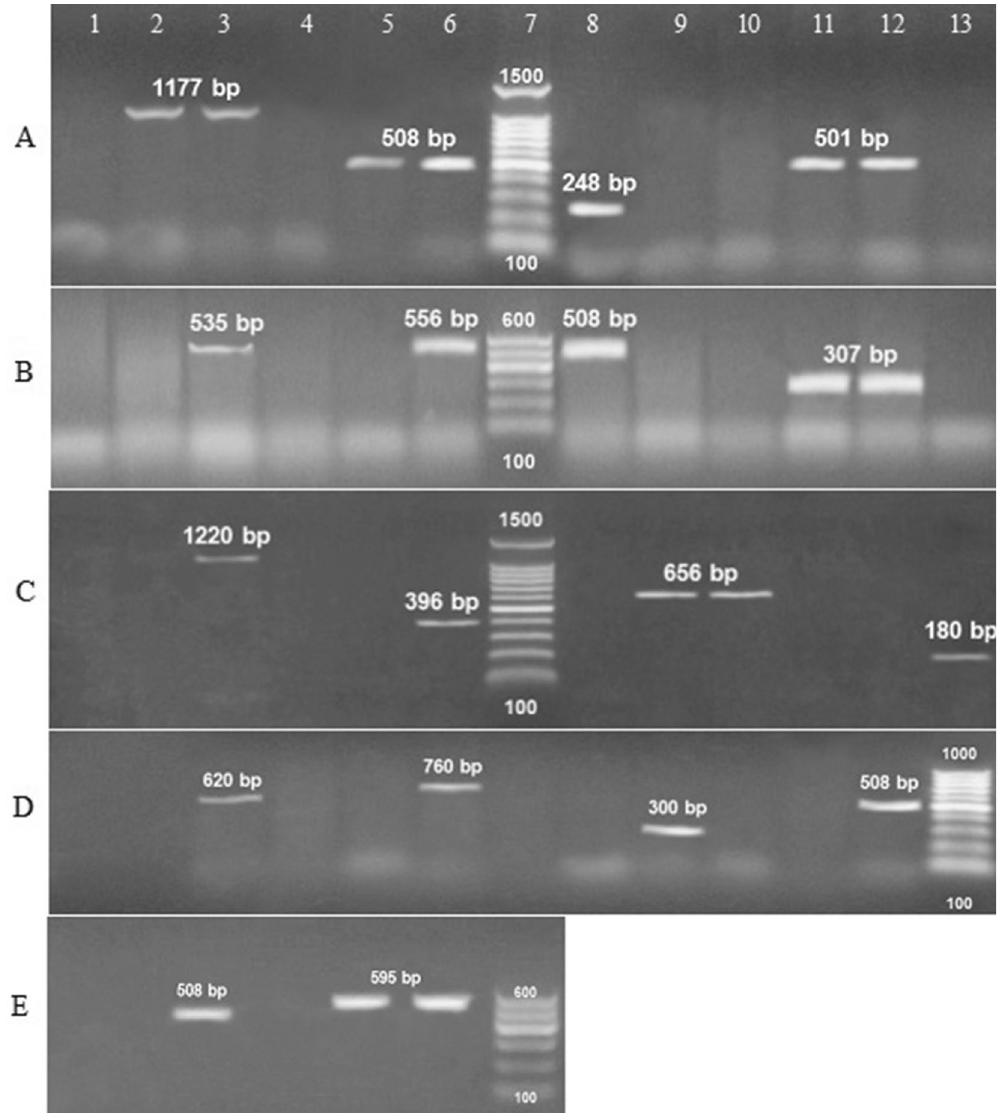
Figure 1. 1.5% agarose gel electrophoresis of multiplex PCR of virulence genes characterized for the isolated uropathogens. ( A ) E. coli ; Lane 1, 4, 10, 13: negative control for detected genes; Lane 3, 6, 8, 11 positive control of DNA confirmed by reference laboratory for quality control; Lane 2 hly (1,177 bp), Lane 5 fim H (508 bp), Lane 9 negative eae A (248), Lane 12 pap C (501 bp); Lane 7 Gel Pilot 100 bp plus ladder (cat. no. 239045) supplied from QIAGEN (USA). ( B ) Klebsiella pneumoniae ; Lane 1, 4, 10, 13: negative control for detected genes; Lane 3, 6, 8, 11 positive control of DNA; Lane 2 negative rmp A (535 bp), Lane 5 negative Tra T (556 bp), Lane 9 negative fim H (508), Lane 12 aerobactin (307 bp); Lane 7, 100 bp ladder as molecular size DNA marker (cat. no. 239035) supplied from QIAGEN (USA). ( C ) Pseudomonas aeruginosa ; Lane 1, 4, 8, 11: negative control for detected genes; Lane 3, 6, 10 and 13: positive control of DNA; Lane 2 negative las B (1,220 bp); Lane 5 negative tox A (396); Lane 9 psl A (656 bp); Lane 12 negative fli C (180 bp); Lane 7 Gel Pilot 100 bp plus ladder (cat. no. 239045) supplied from QIAGEN (USA). ( D ) Acinetobacter baumanii; Lane 1, 4, 7, 10: negative control for detected genes; Lane 3, 6, 9 and 12: positive control of DNA; Lane 2 negative cnf 1 (620 bp); Lane 5 negative cva C (760); Lane 8 negative iut A (300 bp); Lane 11 negative fim H (508 bp); Lane 13 Gene ruler 100 bp DNA ladder (cat. no. SM0243) supplied from Fermentas. ( E ) Proteus mirabilis; Lane 1 and 4: negative control for detected genes; Lane 3 and 6: positive control of DNA; Lane 2 negative fim H (508 bp); Lane 5 atp D (595 bp); Lane 7, 100 bp ladder as molecular size DNA marker (cat. no. 239035) supplied from QIAGEN